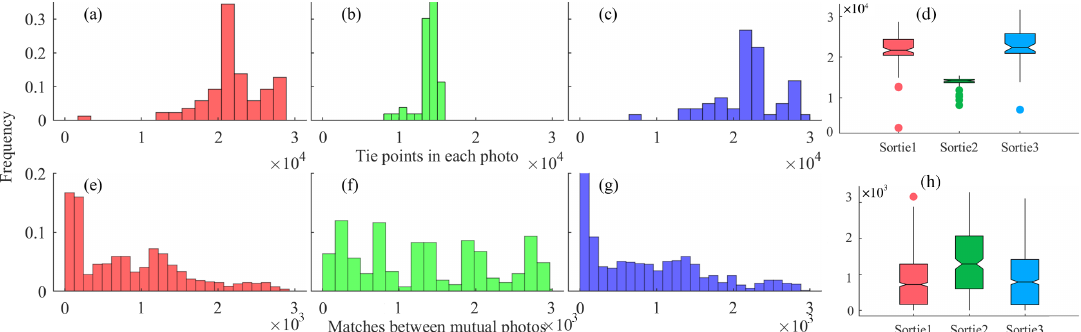
Figure 6. The histogram of tie-points quantity distribution in each photo from the three sorties: ( a ) Sortie-1, ( b ) sortie-2, and ( c ) sortie-3, ( d ) The notched box plot of the previous variable in the three sorties. The histogram of match quantity distribution in mutual photo pairs from the three sorties: ( e ) Sortie-1, ( f ) sortie-2, and ( g ) sortie-3, ( h ) The notched box plot of the previous variable in the three sorties. Note that the scale of the horizontal axis in the histogram plot is the same as that of vertical axis in the box plot in each